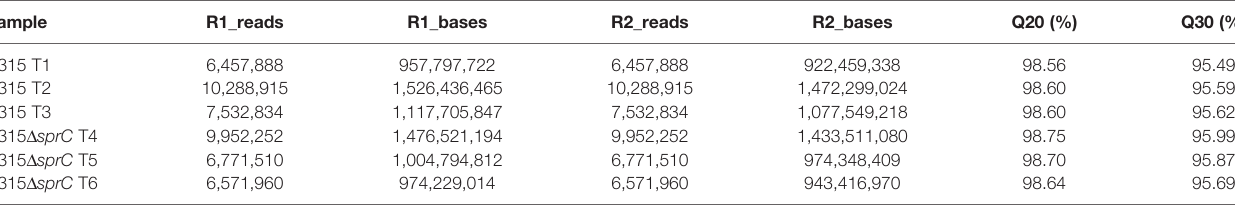
TABLE 1 | The RNA-seq data after quality checking for 6 samples of S. aureus N315 and N315 D sprC .